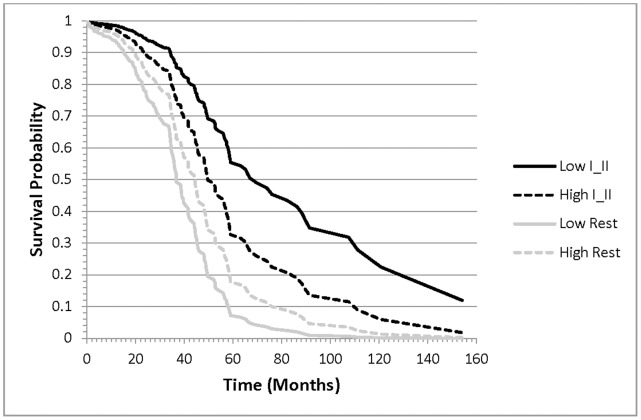
Probability of ovarian cancer survival for patients that have lower grade (I and II) tumors (black lines) or higher (Rest) grade tumors (gray lines) and high (dashed lines) or low (solid line) levels of hsa-miR-521.